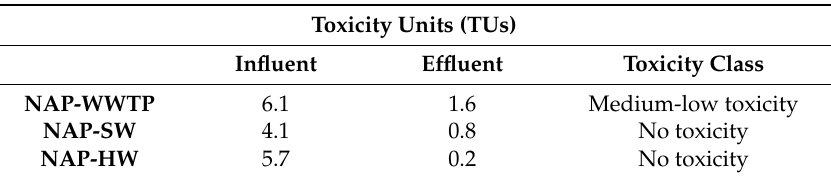
Table 8. Toxicity values of the tested real-aqueous